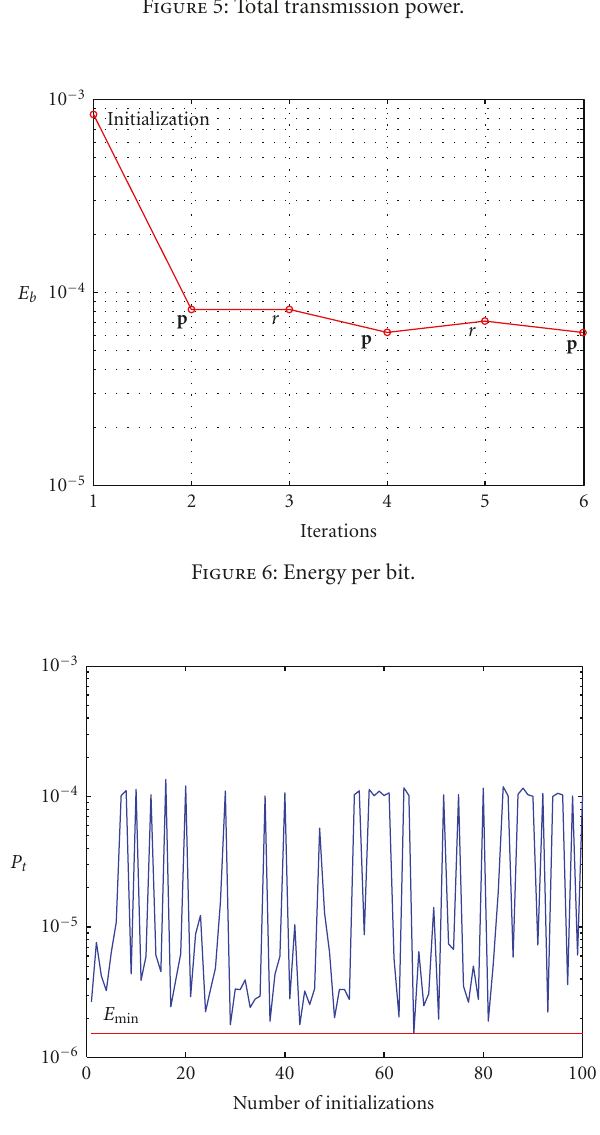
Figure 7: Energy function for di ff erent initializations.